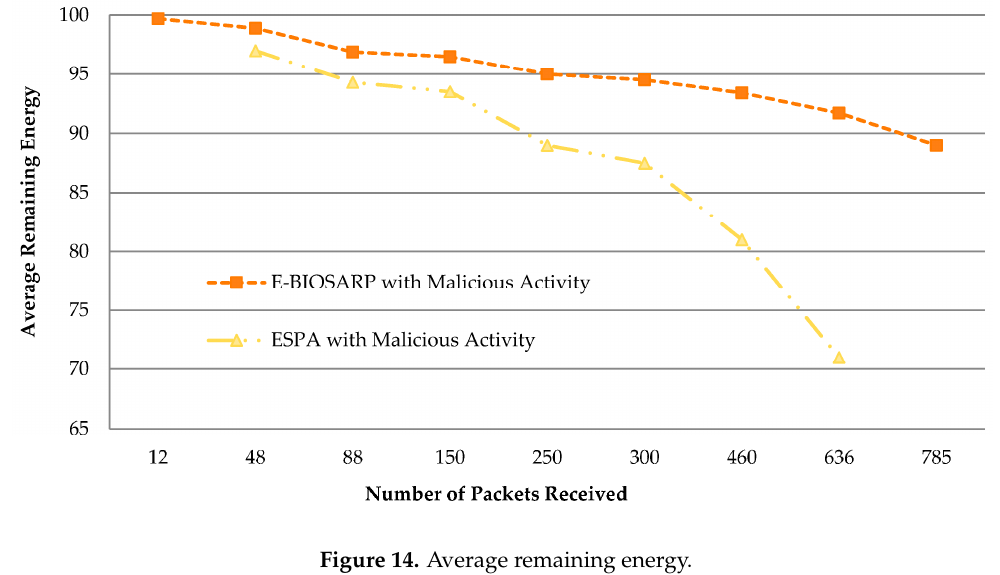
19 of 22 Table 10. Energy consumption comparison. Packet Rate (packets/s)